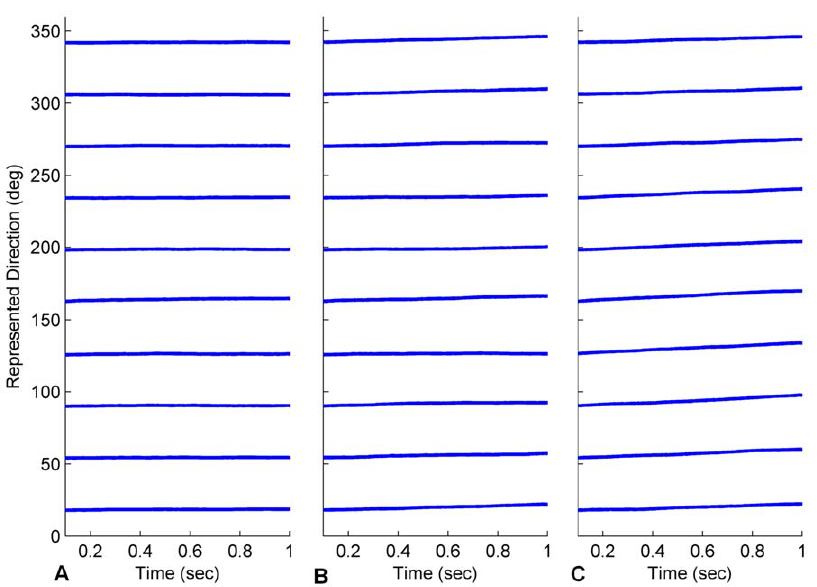
Figure 10. Bump stability varied with different modifications to movement strategy. (A) Small lateral head turns, but no 360 u turns. (B) 360 u turns, but no small head turns. (C) Sensory input uncorrelated with head motion. See text for discussion.